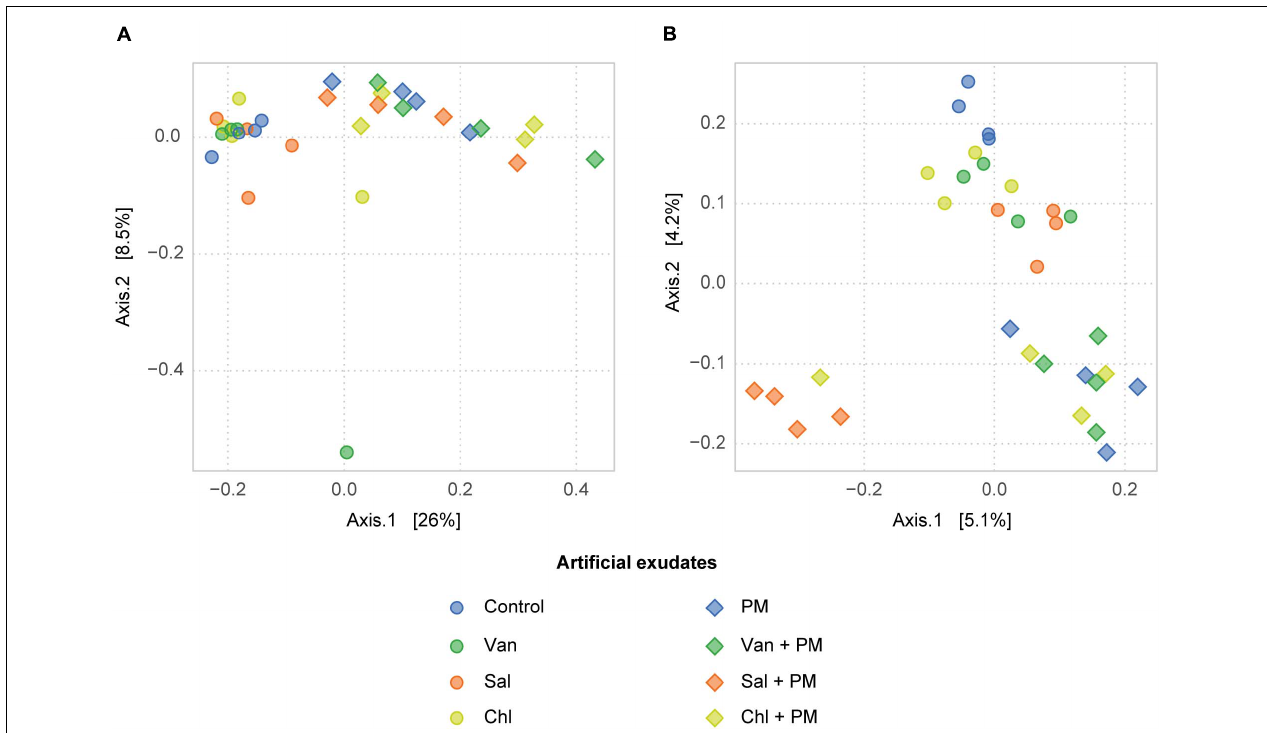
FIGURE 5 | Effect of phenolic acids on fungal (A) and bacterial (B) communities in the arable soil layer of rhizosphere simulation microcosms. PCoA ordination plot based on Bray-Curtis distances. Four replicates are shown for the control, vanillic acid (Van), salicylic acid (Sal) and chlorogenic acid (Chl), applied alone (phenolics only) and with primary metabolites (phenolics +